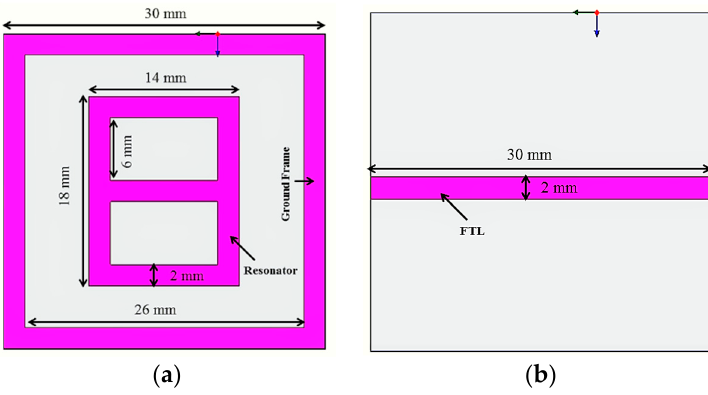
Figure 1. Geometry of the sensor: ( a ) top side, and ( b ) bottom side.